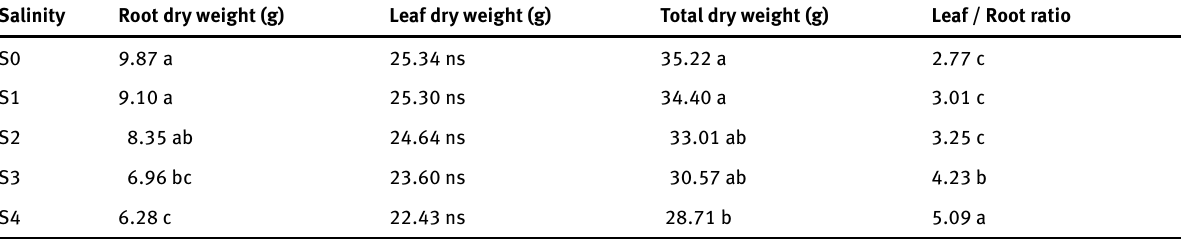
Table 4: Mean values of the tested parameters as affected by different salt doses Salinity